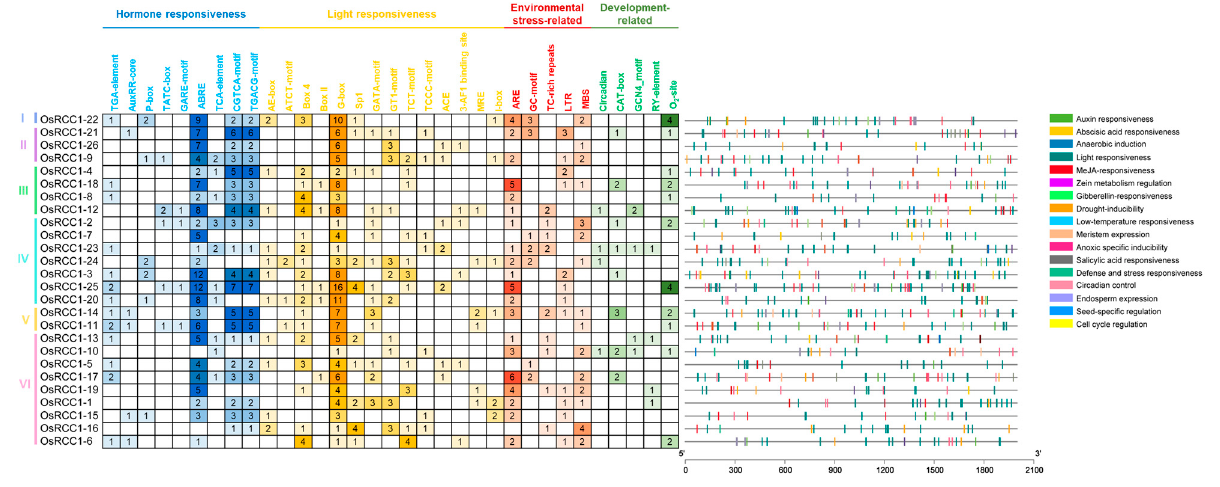
Figure 3. CREs distribution in the promoter regions of OsRCC1s . CREs in the promoter of each OsRCC1 gene are classified based upon the putative functions, including hormone-responsive CREs, light-responsive CREs, environmental stress-responsive CREs and growth and development- responsive CREs. The positional distribution of various CREs on promoters is shown as vertical bars with different colors.